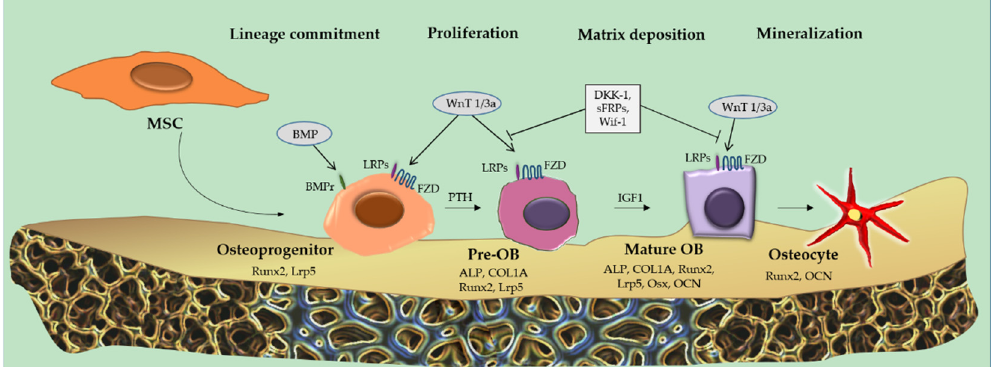
Figure 2. Osteoblastic suppression. Osteoblastic suppression occurs due to inhibition of the Wingless/int1 (Wnt) signaling/ β -catenin pathway. The molecules responsible for the inhibition are dickkopf-related protein 1 (DKK-1), secreted frizzled-related protein (sFRP) and Wnt inhibitory factor (Wif-1), which bind to the low-density lipoprotein receptor-related protein receptors (LRPs). Runt-related transcription factor 2 (Runx-2) and Osterix (Osx), two fundamental genes for osteoblastic differentiation, are downregulated. Abbreviations: Wnt/ β -catenin: wingless/int1 (Wnt) signaling/ β -catenin pathway; DKK-1: dickkopf-related protein 1; sFRP: secreted frizzled-related protein; Wif-1: wnt inhibitory factor; LRPs: low-density lipoprotein receptor-related protein receptors; Runx-2: runt-related transcription factor 2; Osx: osterix.